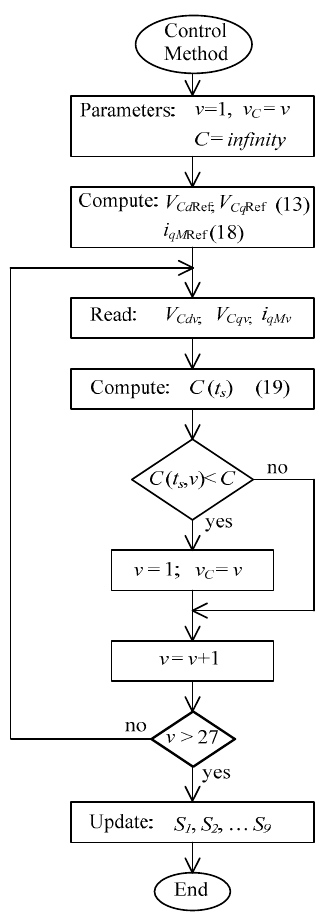
Figure 4. Control scheme of the real time Lyapunov-based controller of the DMC-UPFC.